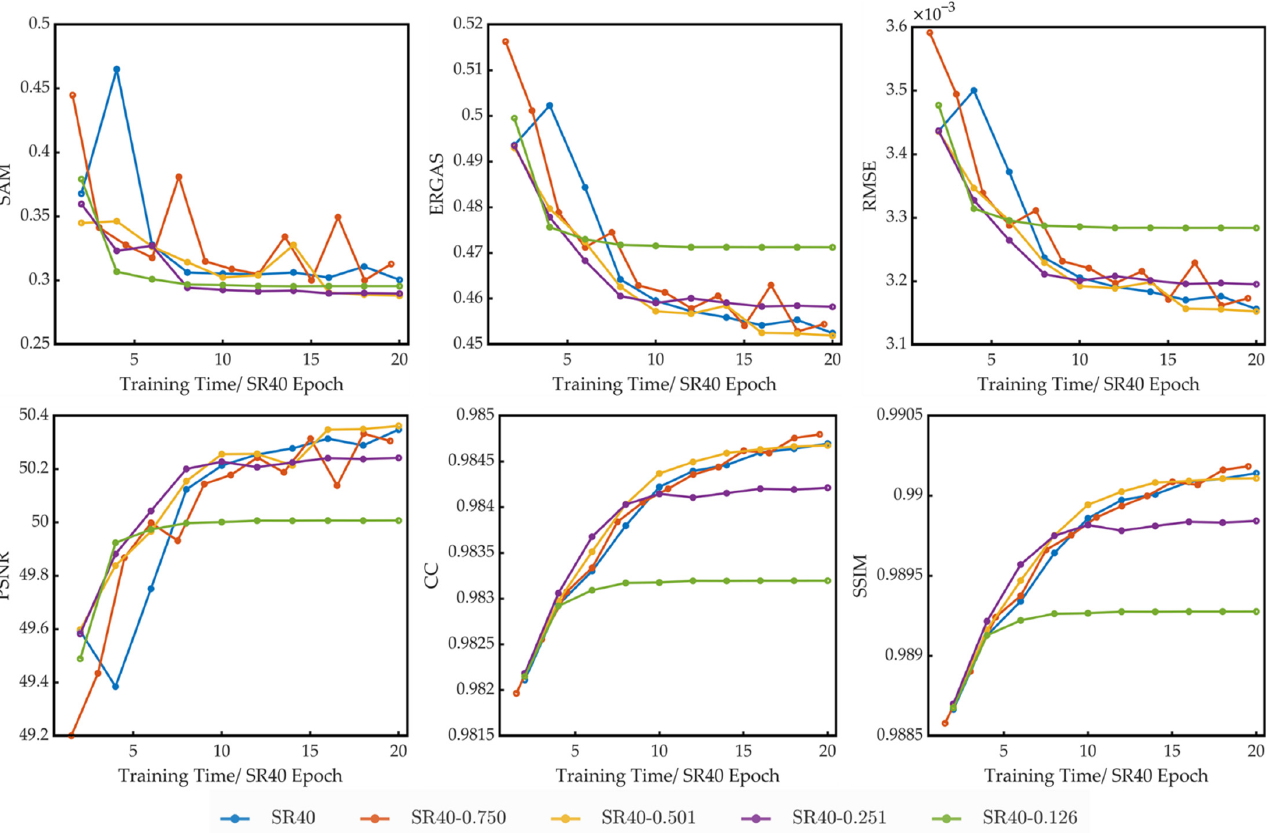
Figure 11. The performance of models trained on different spatial compression datasets with different training times.